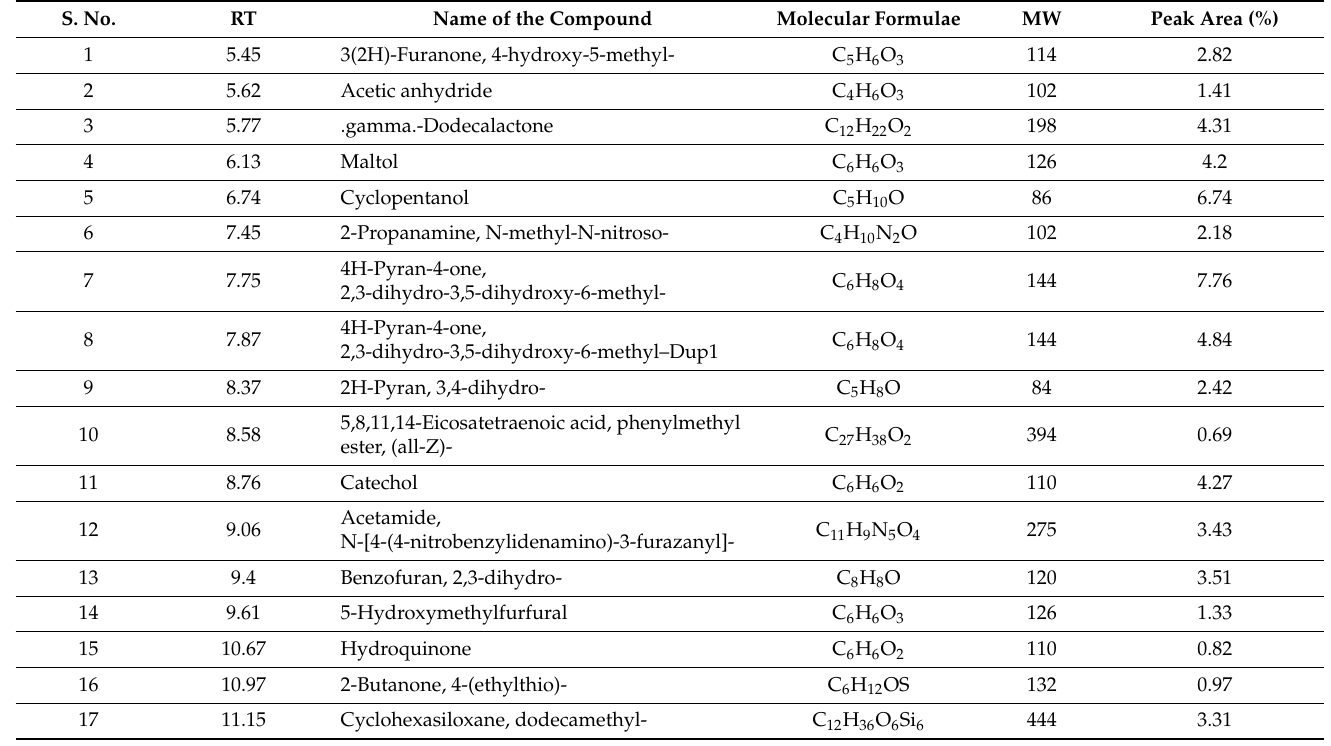
Table 7. Compounds identified in ethanolic-extracted C. tinctorius